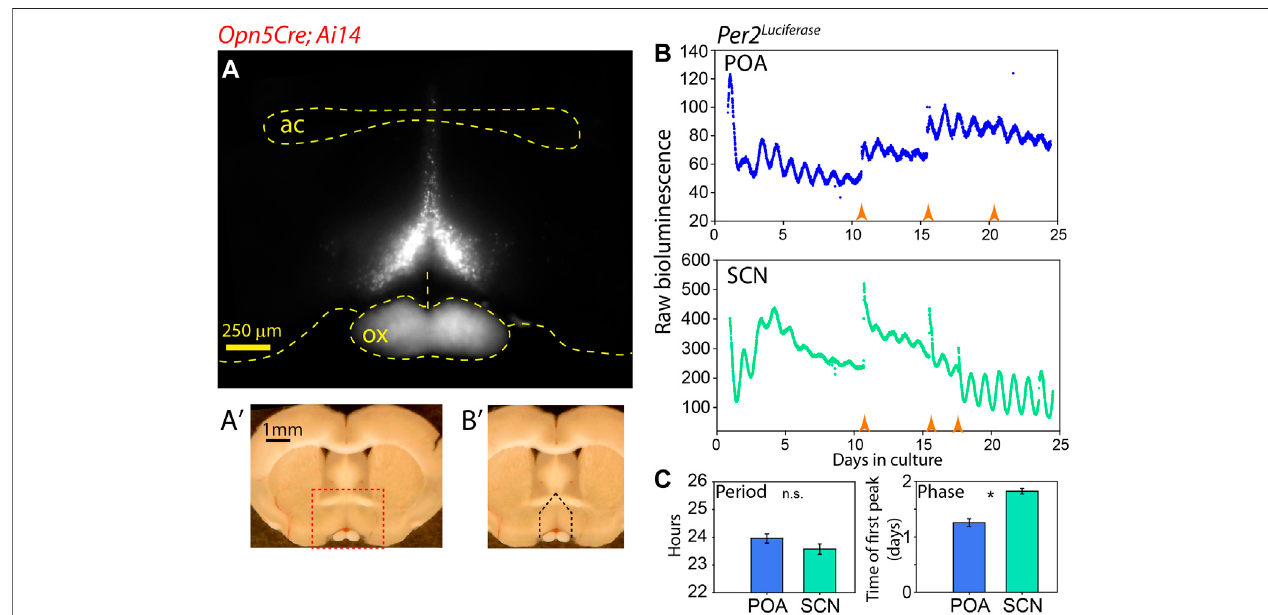
FIGURE1| AutonomousclockregionnearOpn5expressioninPOA. (A) FluorescenceimageoftdTomatoexpressionincoronalsectionof Opn5 Cre/+ ;Ai14 mouse. “ ac ” =anteriorcommisure, “ ox ” =opticchiasm. (A ′ ) WholebrainsliceshowingregionofdetailinAasreddashedbox. (B ′ ) Sameimageas (A ′ ) showingareaofdissection for PMT measurement as black dashed lines. (B) Bioluminescence of Per2 Luciferase from a coronal POA region as highlighted in (B ′ ) (upper), and from the SCN of the same mouse (lower). Orange arrow indicate times of media change. (C) Free-running period (left) of and peak time of fi rst full oscillation of Per2 Luciferase bioluminescence POA and SCN from the same mice. Mean ± SEM are shown for n = 8. * = p < 0.05 paired t